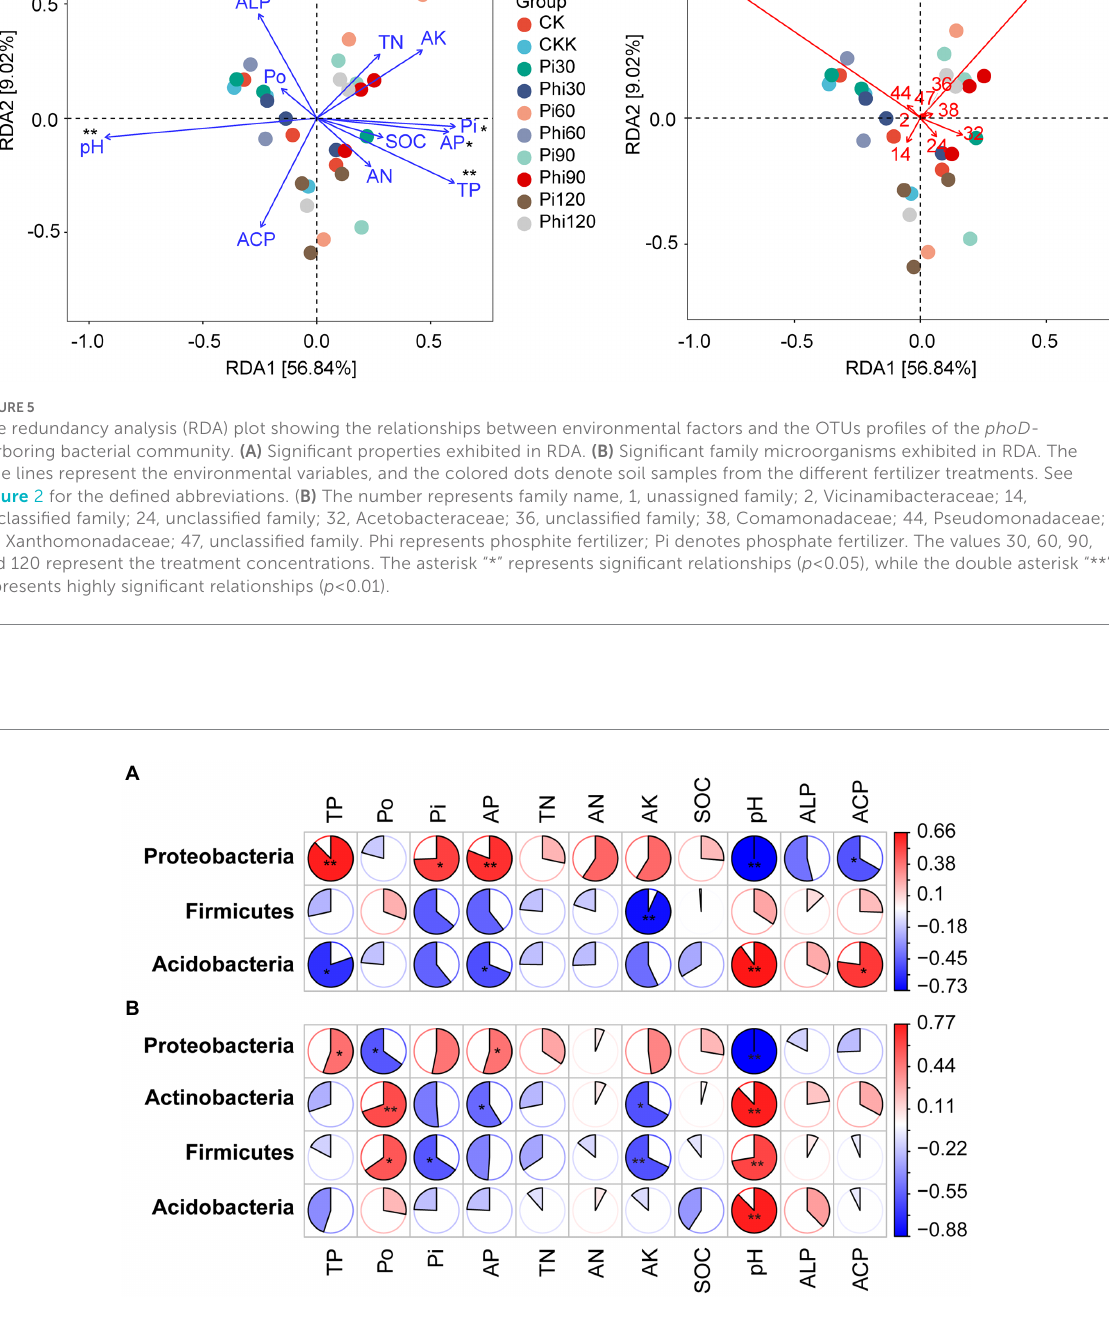
FIGURE 6 The matrix of the Spearman correlation coefficients showing the phyla of phoD -harboring bacteria and soil physicochemical properties under phosphate fertilizer (A) and phosphite fertilizer (B) . See Figure 2 for the defined abbreviations. The circle indicates larger correlation coefficients, and only significant correlations ( p < 0.05) are included. The asterisk “*” represents significant relationships ( p < 0.05), while the double asterisk “**” represents highly significant relationships ( p < 0.01). The coefficient Spearman correlation ranges from − 0.73 (blue) to 0.66 (red) under phosphate fertilizer and − 0.88 (blue) to 0.77 (red) under phosphite fertilizer.